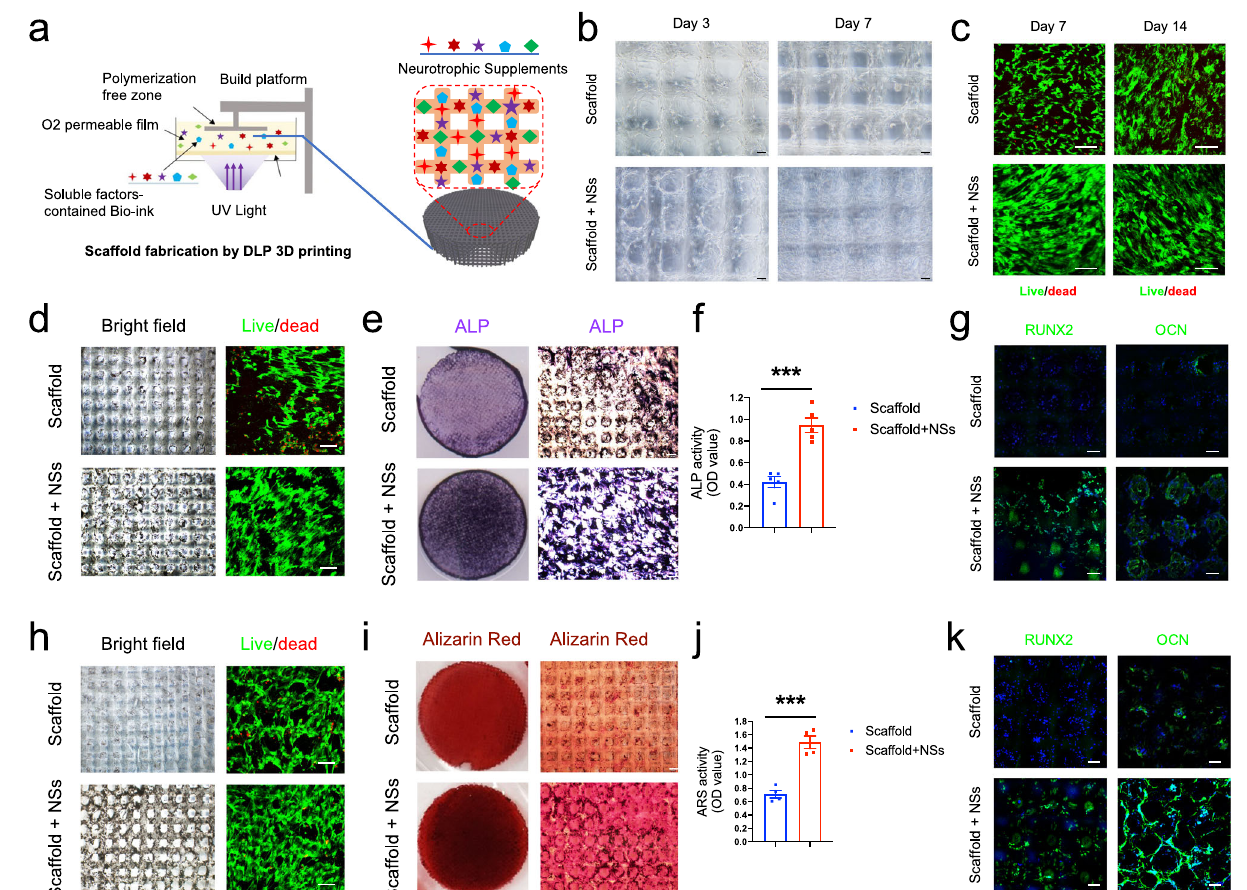
Fig. 1 | 3D printed hydrogel scaffold with NSs enhances in vitro expansion and osteogenic potential of MSCs. a Schematic diagram of NSs-loaded 3D printing gel scaffold by DLP technology. b Bright fi eld image of MSCs distribution and cellmorphologyonthesurfaceandinsideofthe gelscaffoldandNSs-loadedgel scaffold for 3 days and 7 days, bar=200 μ m. c Live/Dead staining (Green, live cells; Red, dead cells) of MSCs expanded on gel scaffold and NSs-loaded gel scaffold for 7 days and 14 days, bar=50 μ m. d Bright fi eld image and Live/Dead staining (bar=200 μ m, 50 μ m); e Gross view and f ALP staining, bar=100 μ m, Exact p value calculated with unpaired t -test: *** p =0.0003, n =5 biologically independent samples; g immunostaining of RUNX2 and OCN after 7 days ’